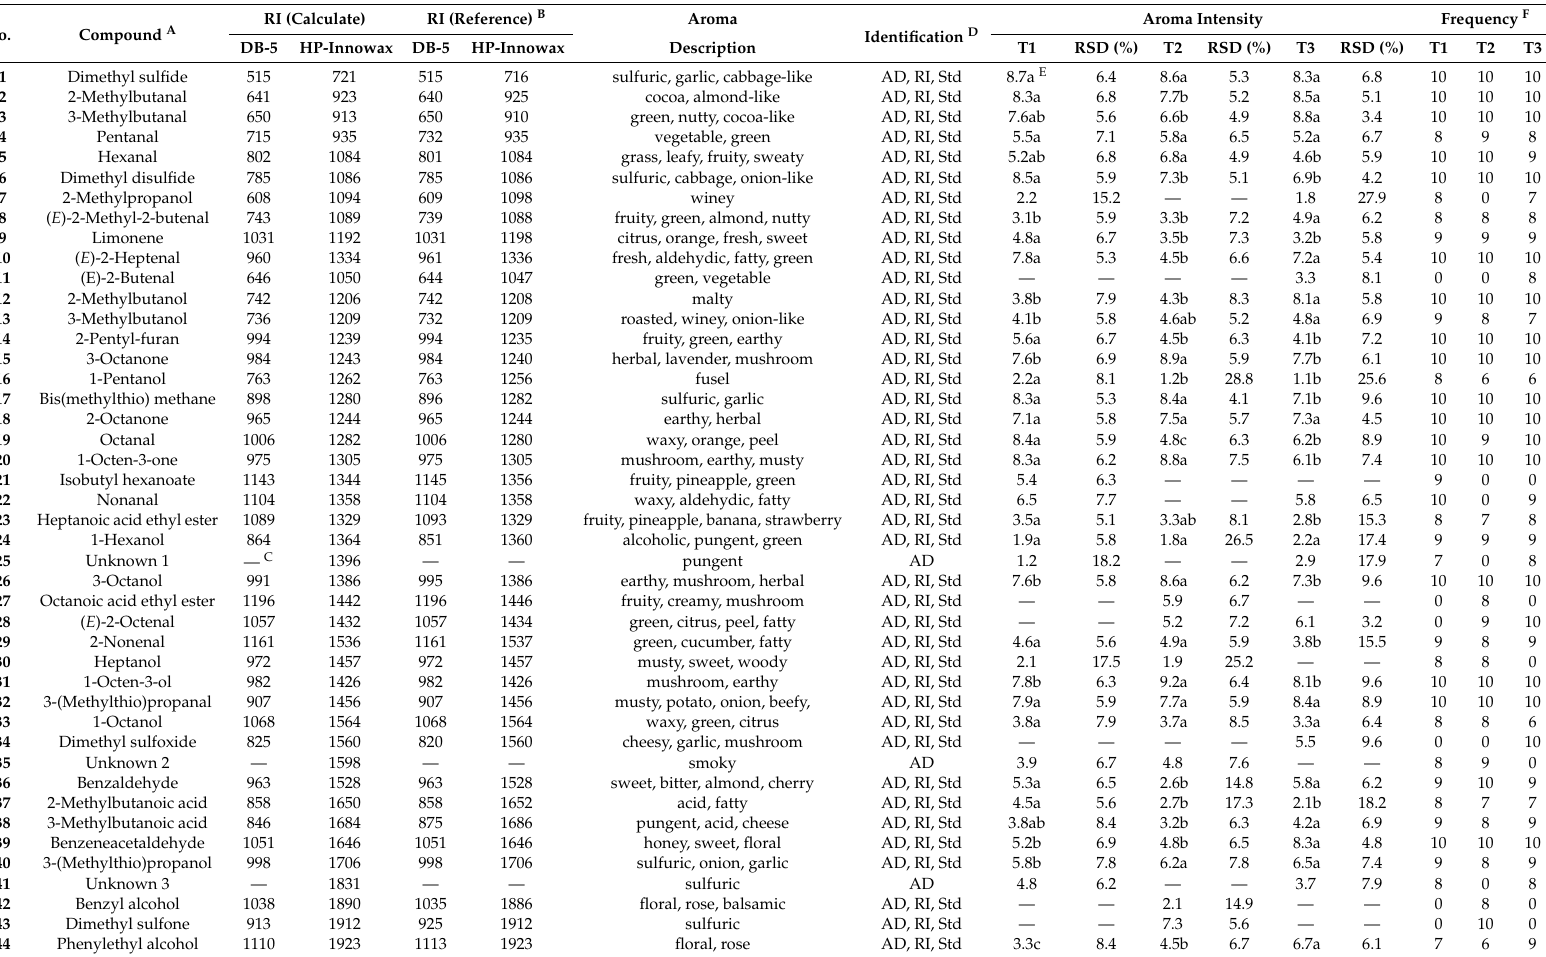
Table 1. GC-O identified aroma-active compounds in tru ffl e